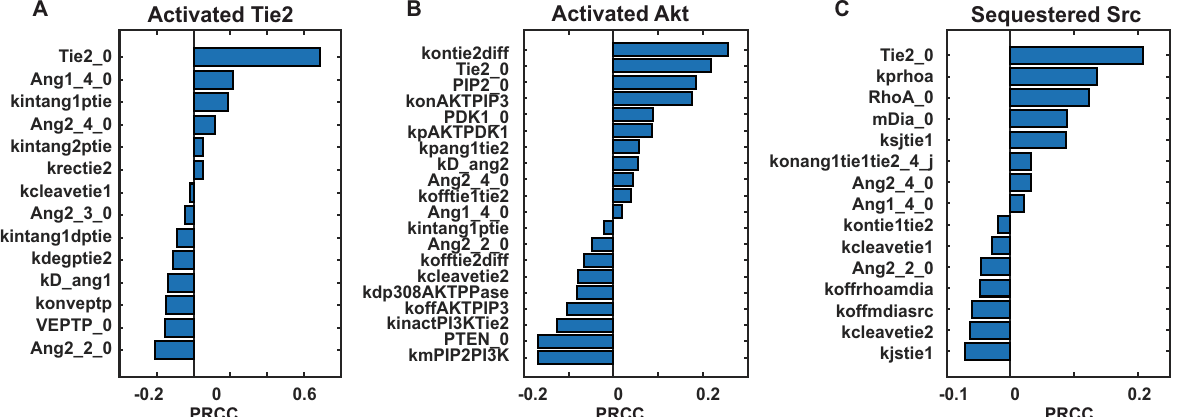
Fig. 6 Global sensitivity analysis using LHS/PRCC. Partial rank correlation coef fi cients for signi fi cantly sensitive parameters (having nonzero PRCC values with Bonferroni-corrected p -values < 0.05) for A activated Tie2, B activated Akt, and C sequestered Src. Positive PRCCs indicate that an increase in the parameter is correlated with a positive change in the model output; negative PRCCs indicate that an increase in the parameter is correlated with a negative change in the model output.